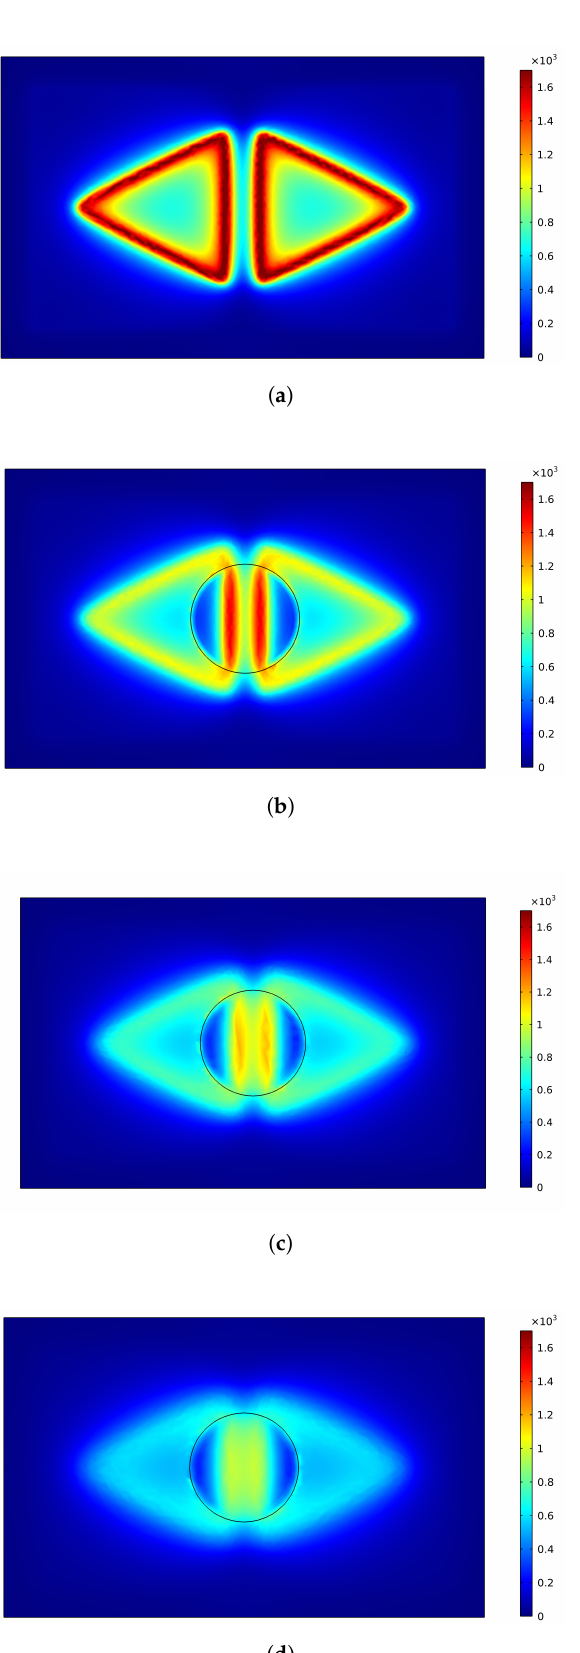
Figure 7. Simulations of the electric field distribution (V/m) for a sample in z = 0 plane: ( a ) no